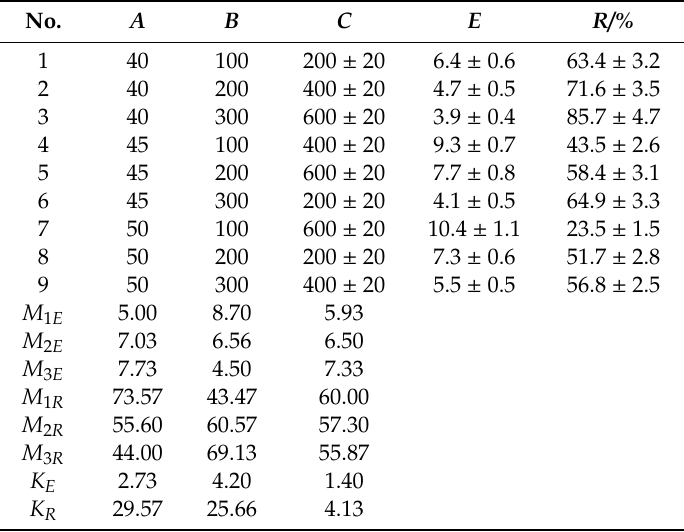
Table 8. The direct analyses for the results of the orthogonal